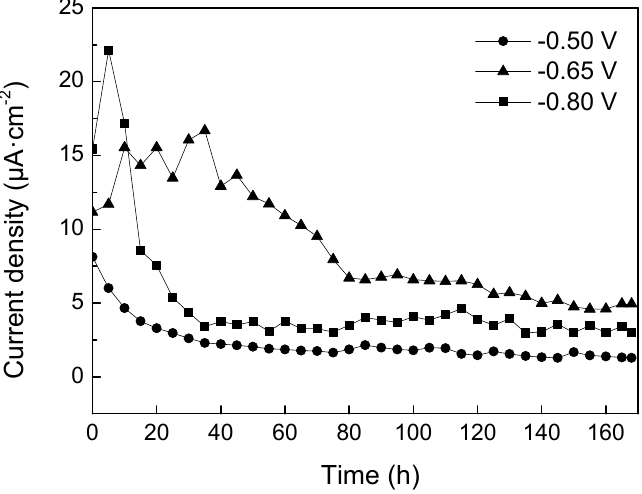
Figure 2. Variation of current density with potentiostatic polarization of 304 SS at different cathodic potentials in seawater.